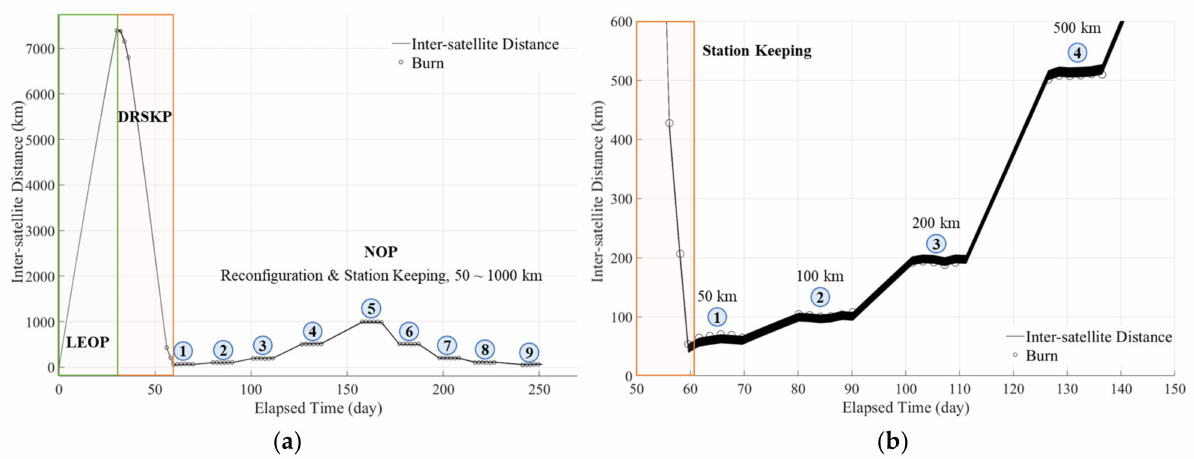
Figure 3. Profiles of inter-satellite distance with orbit maneuver scenarios using multiple burns. Blue circles denote a repeat count of the reconfiguration and station keeping maneuvers: ( a ) entire phases from launch and separation; ( b ) normal operation phase with reconfiguration and station-keeping maneuvers for adjusting inter-satellite